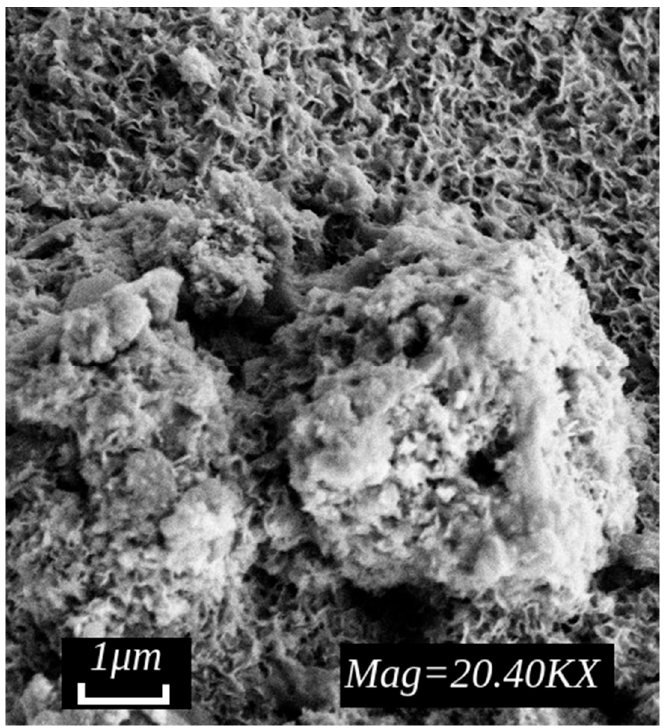
Figure 5. Electronic microphotograph of the steel St3 surface after 60 days of exposure. Linear structure—FeO(OH); bulk structure—CaCO 3 and its co-crystallized components.